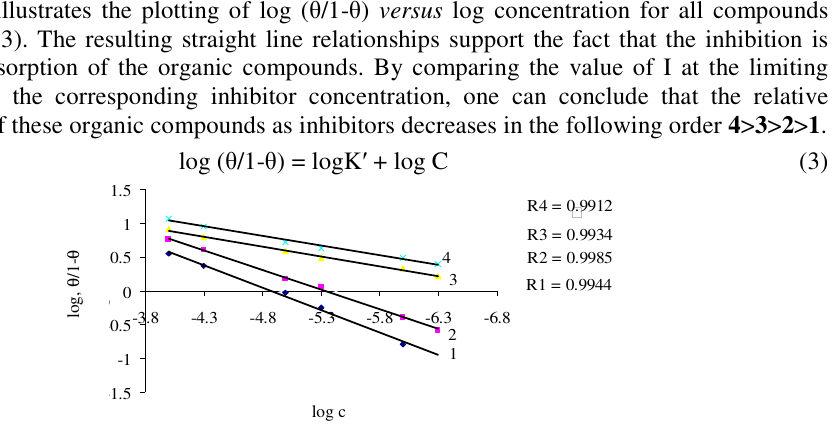
Figure 3. log ( θ /1- θ ) vs . log C curves for corrosion of copper in the presence of different concentrations of all flavonoids derivatives at 25 °C.